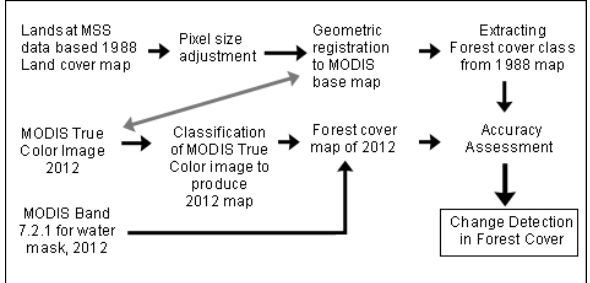
Figure 3. The flow of data processing. The production process of 1988 map is not included in detail